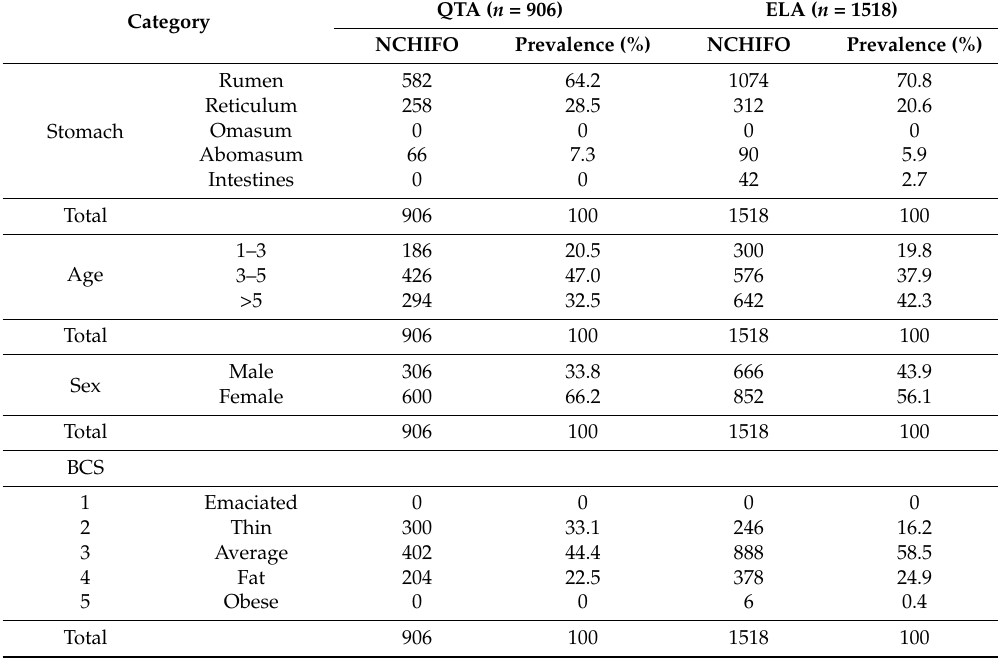
Table 2. Number of IFOs according to location, age, sex and body condition scoring in cattle slaughtered in QTA and